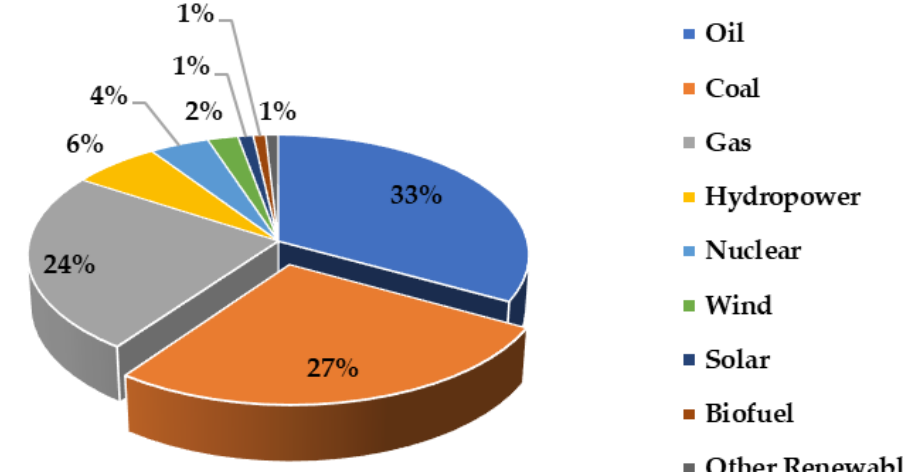
Figure 1. The percentages of global energy generation contribution by various energy sources.